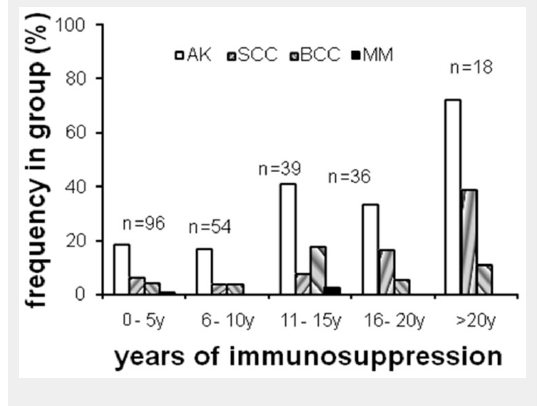
Correlation between years of immunosuppression and development of actinic keratoses (AK), squamous cell carcinomas (SCC), basal cell carcinomas (BCC) and melanoma